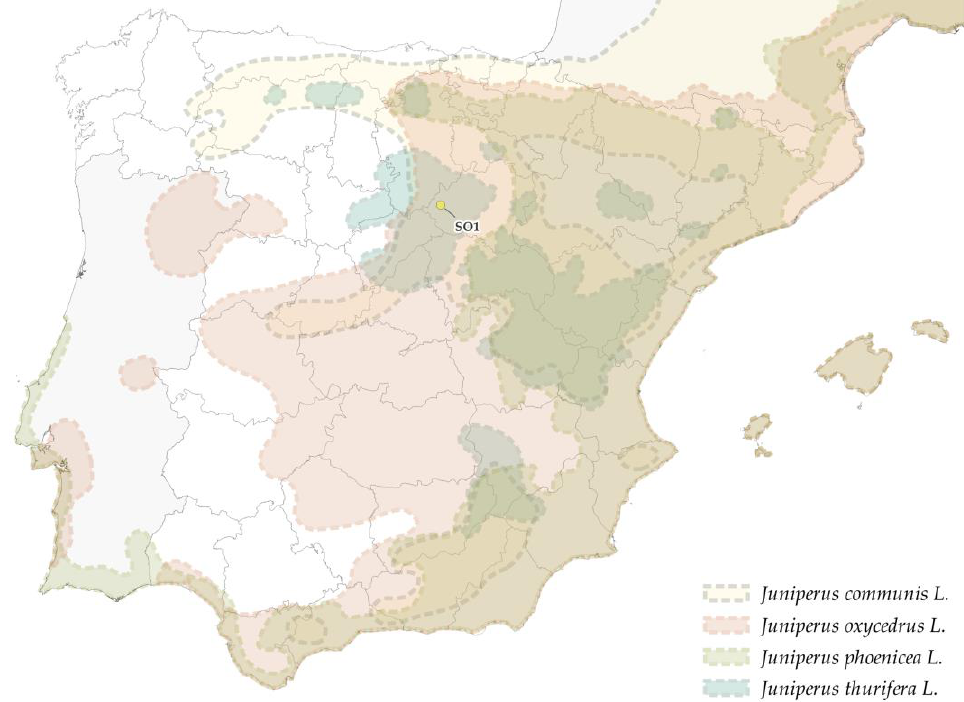
Figure 23. Distribution map for the species Juniperus communis L., Juniperus oxycedrus L., Juniperus phoenicea L., and Juniperus thurifera L . and locations of case studies identified as belonging to this species group. Map drawn up by the authors using information obtained from the database Chorological Data for the Main European Woody Species [42].